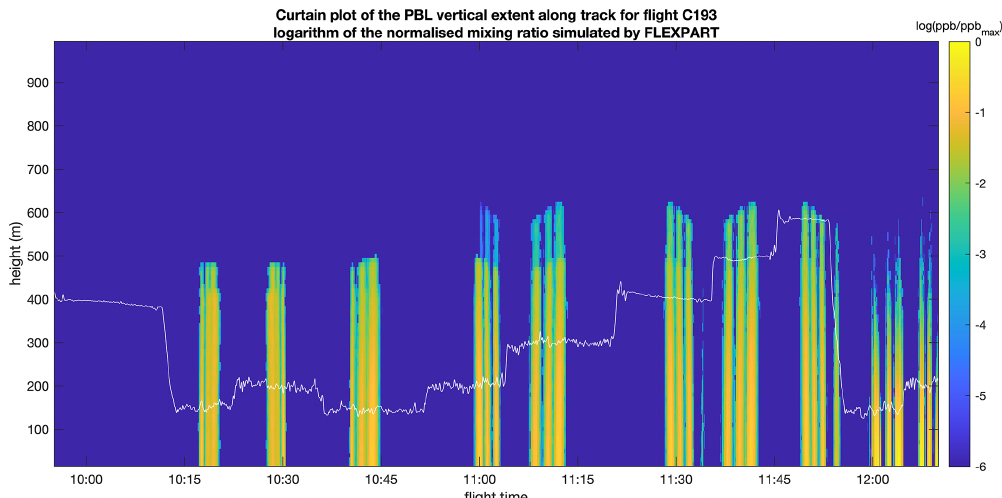
Figure A1. Example curtain plot for the forward FLEXPART simulation for FAAM flight C193 used to estimate modelled plume height. The white line denotes the flight altitude, and the shaded area denotes the logarithm of the normalised volume mixing ratio of CH 4 (column containing each measurement).